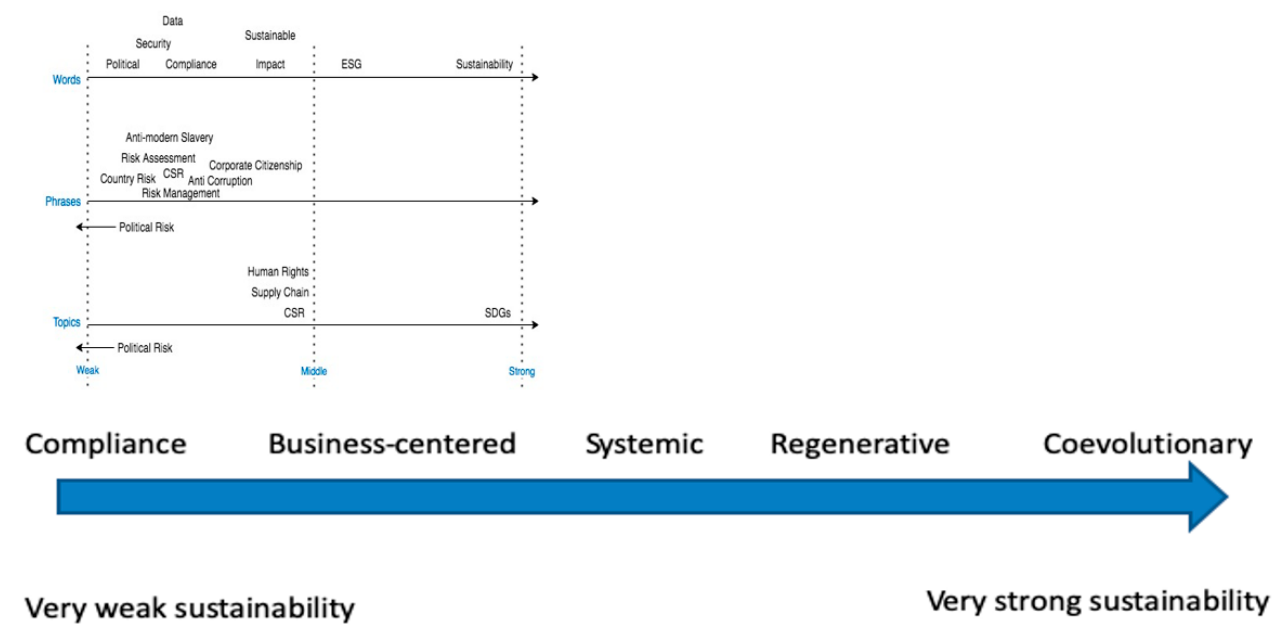
Figure 3. Corporate sustainability spectrum for political risk analysis.